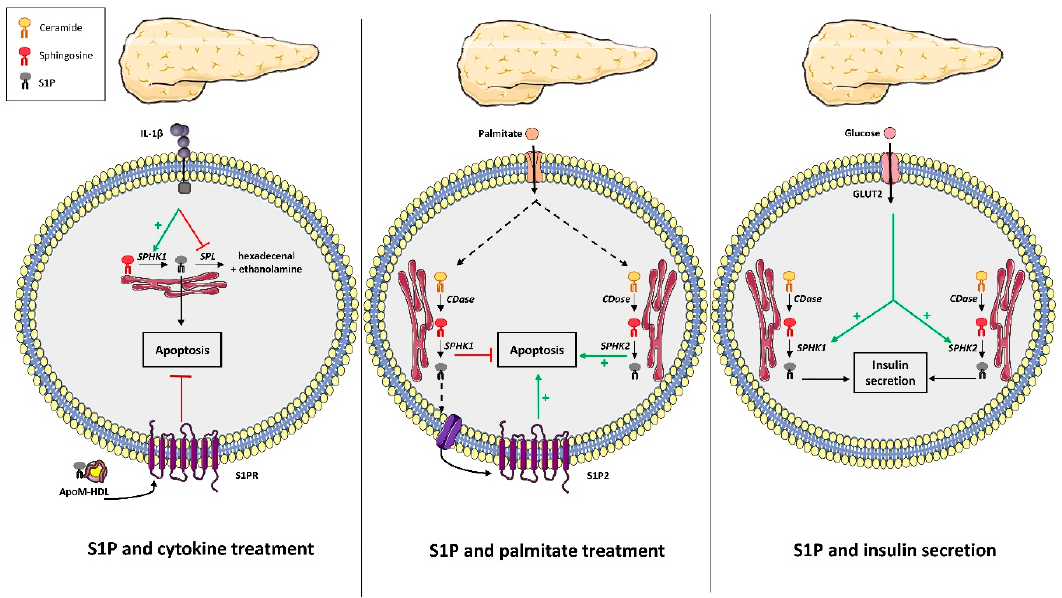
Figure 3. Role of S1P metabolism on pancreatic β cell fate. In pancreatic β cells, cytokines, such as IL1 β increase SphK1 expression and repress SPL expression. This contributes to the increase of intracellular S1P content and apoptosis. In contrast, extracellular ApoM / HDL-bound S1P y antagonizes apoptosis induced by IL1 β . In pancreatic β cells, palmitate increases the expression of both SphK1 and2. SphK1 activation represses palmitate-induced pancreatic β cell apoptosis, whereas SphK2 activation promotes apoptosis. SphK1-produced S1P can be secreted and stimulates S1P2 to promote apoptosis. High glucose levels could activate both SphK1 and 2, which contribute to the secretion of insulin. CDase: ceramidase. SPL: S1P lyase. SphK: sphingosine kinase. S1P2: S1P receptor